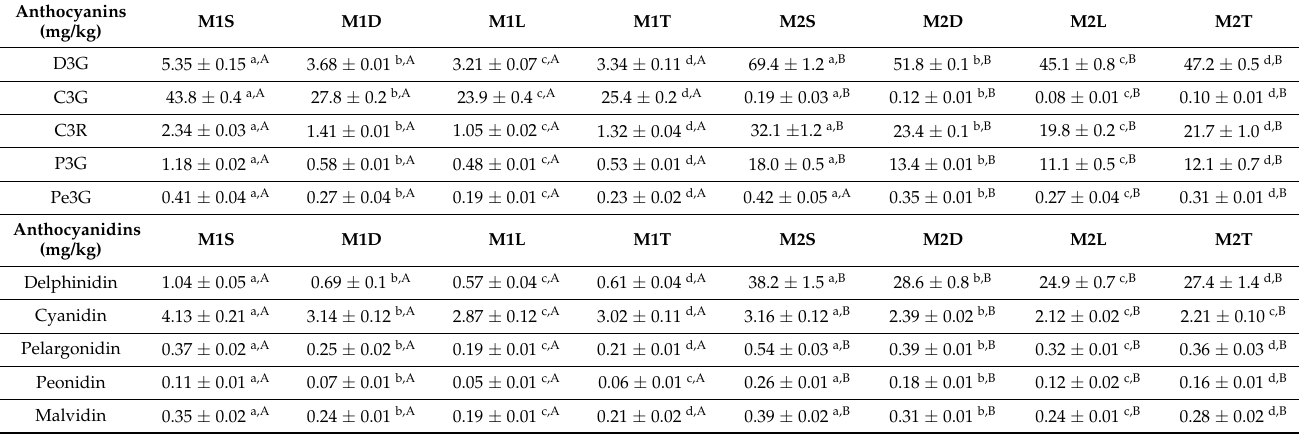
Table 3. Individual anthocyanin and anthocyanidin contents of the M1 and M2 nutraceutical mixtures under the defined storage conditions.